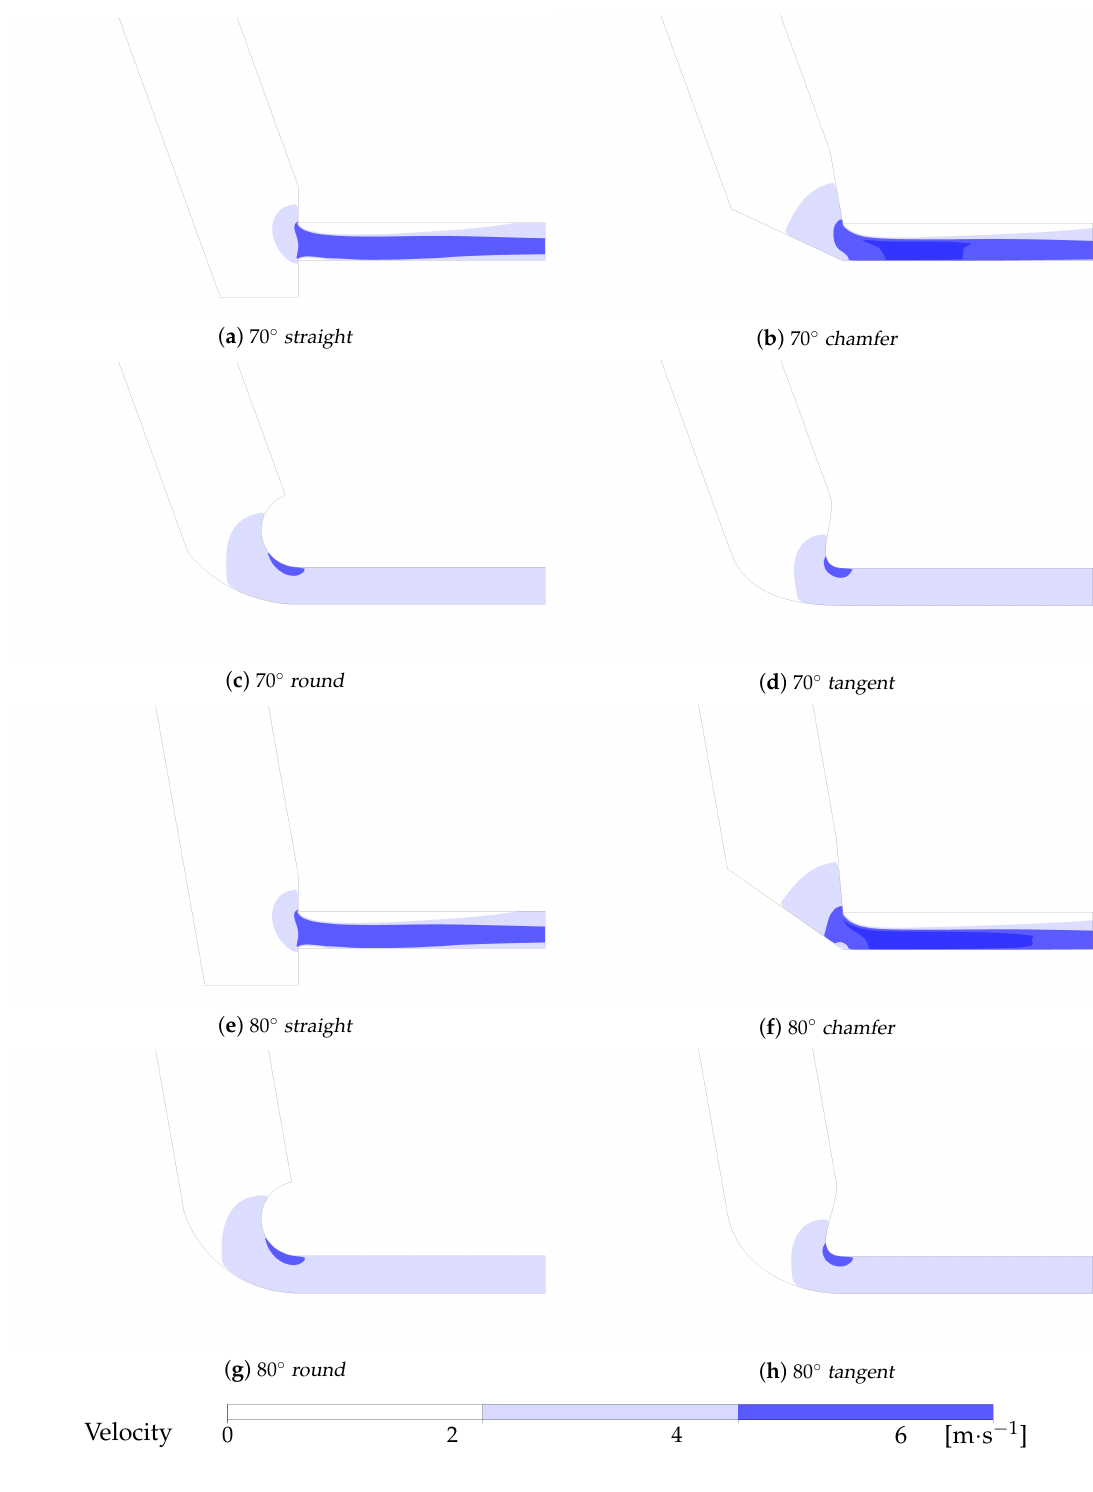
Figure A5. Velocity Contours for 70 ◦ and 80 ◦